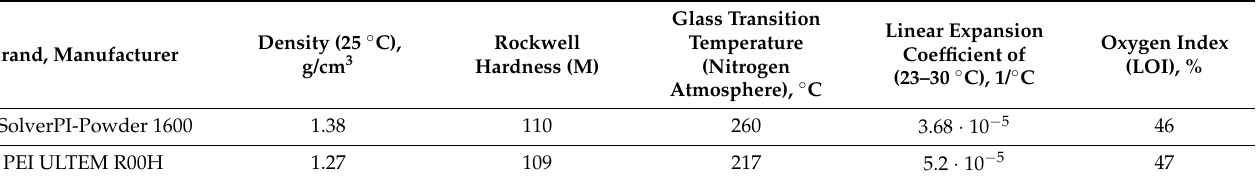
Table 1. Key physical and chemical properties of PI and PEI.